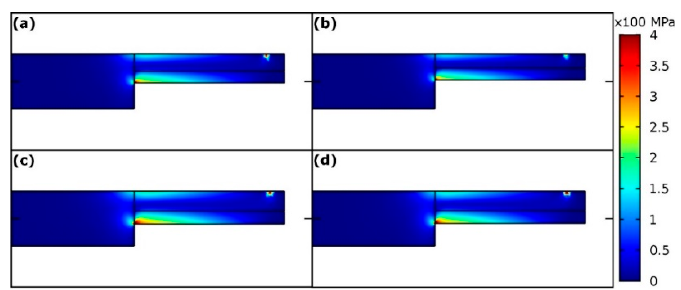
Figure 4. The vertical mirror plane (red color) of the microcantilever.